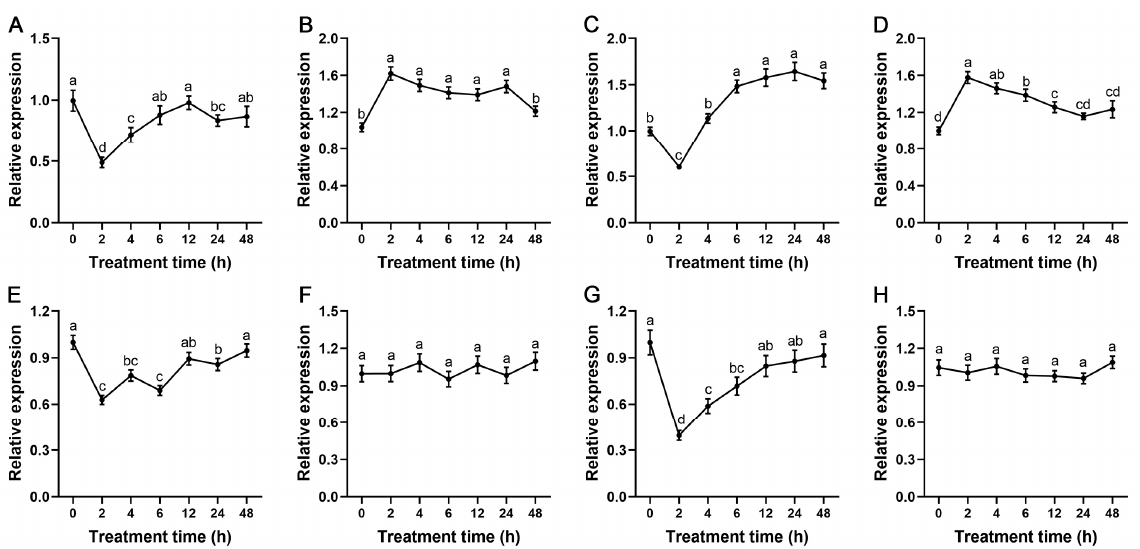
Figure 7. The relative expression level of StSnRK2 genes under 50 µM ABA stress treatments. Data represent the means ± SD of three replicates, and different letters indicate significant differences at p < 0.05. ( A – H ) StSnRK2.1 – StSnRK2.8 , respectively.